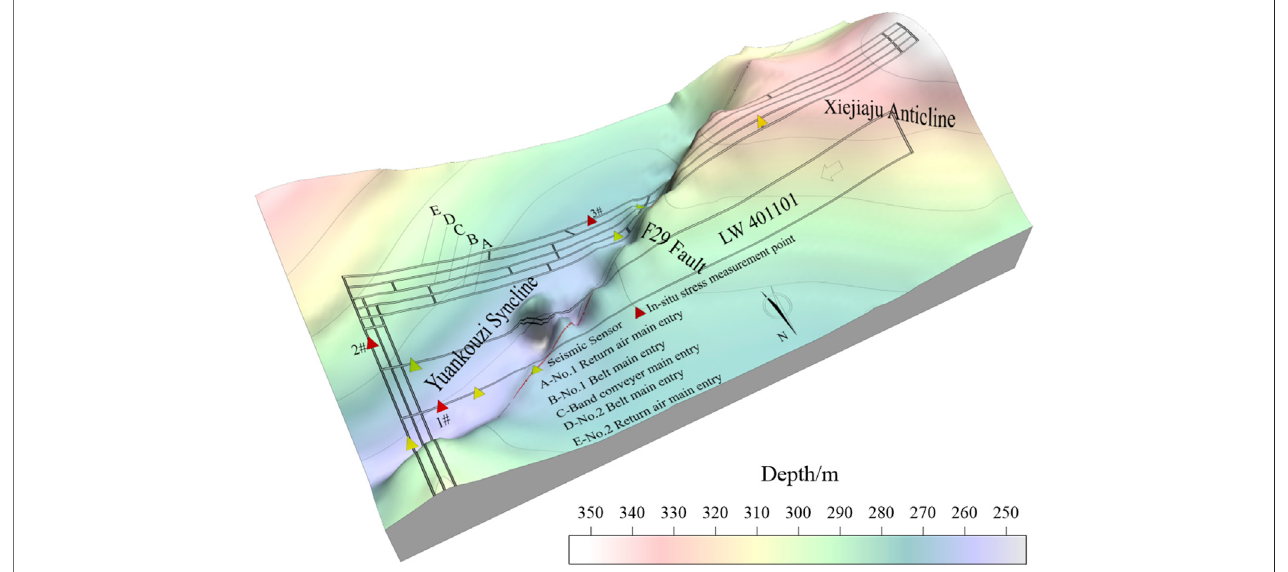
FIGURE 1 | 3D view of a mine ’ s working face, geological structure, ground stress and microseismic measurement point.